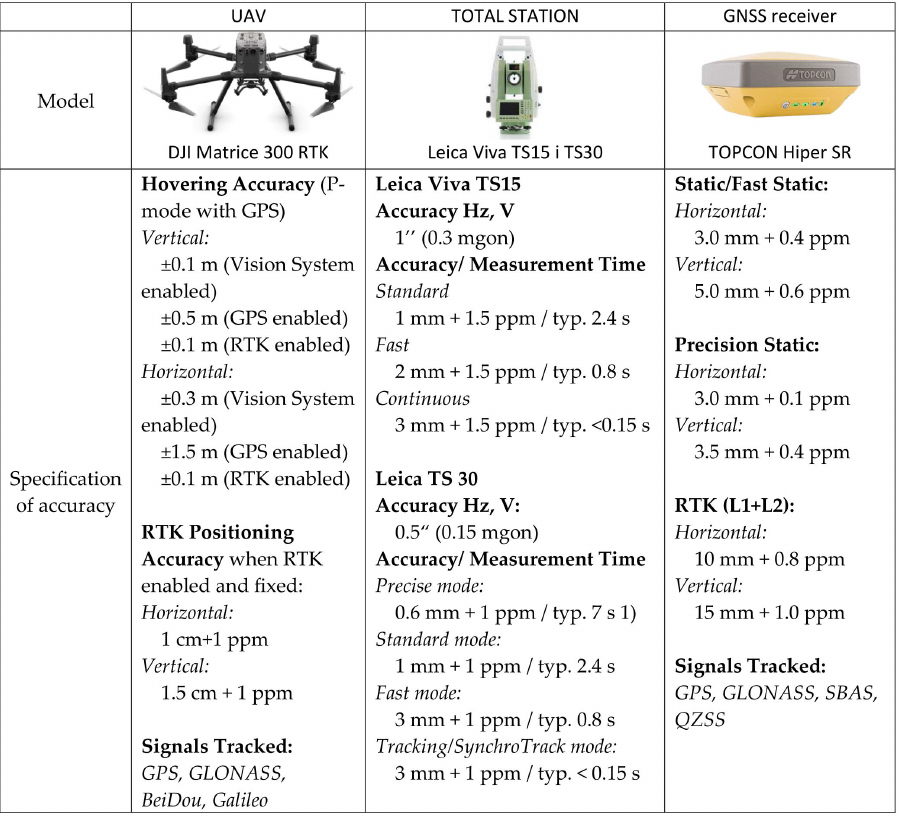
Figure 3. Assessment of the accuracy of used equipment.